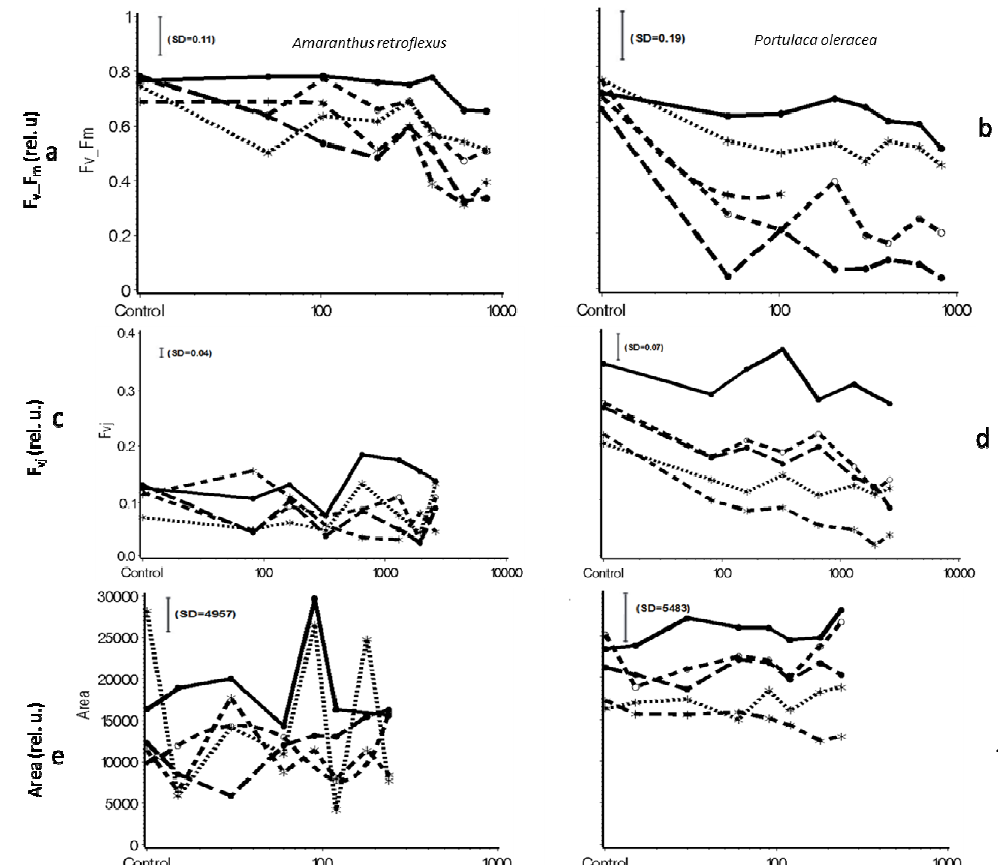
/F in Amaranthus retroflexus (a) and Portulaca oleracea v m